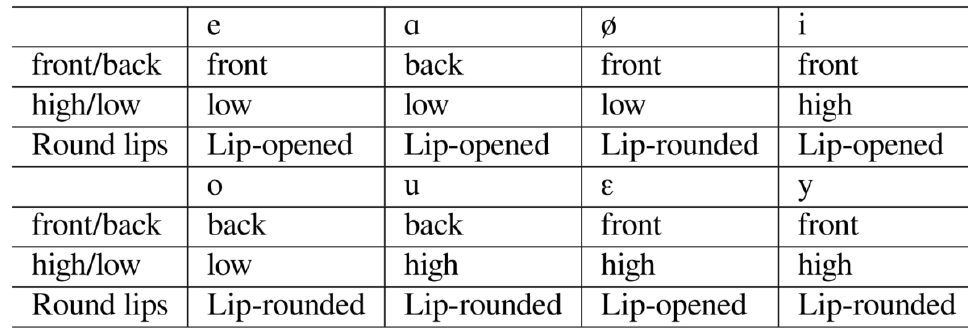
Figure A1. Uyghur